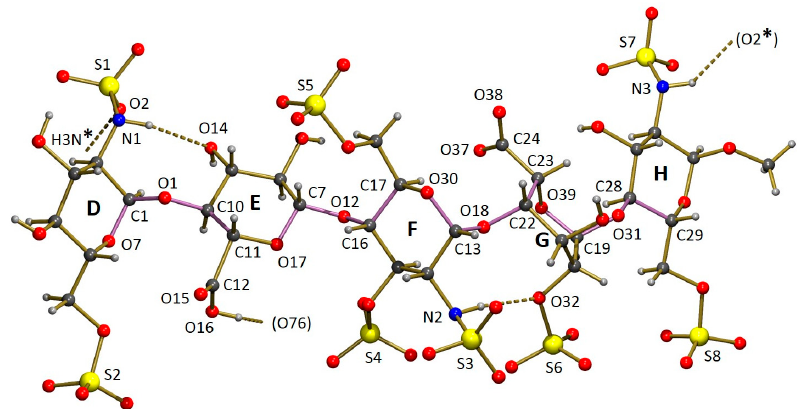
Figure 5. Perspective drawing of part of the asymmetric unit of the crystal structure of Fondaparinux. Sodium ions and water molecules (coordinated and non-coordinated) are excluded for clarity. Rings and atoms mentioned in the discussion are labelled. The bonds defining the glycosidic conformation are highlighted in pink. Hydrogen bonds are marked with dashed lines. N3-H3N donates a hydrogen bond to a translation related Fondaparinux molecule ( x − 1, y , z − 1). The involved symmetry positions are indicated with a *. Hydroxyl O16 donates a hydrogen bond to a water molecule not shown.